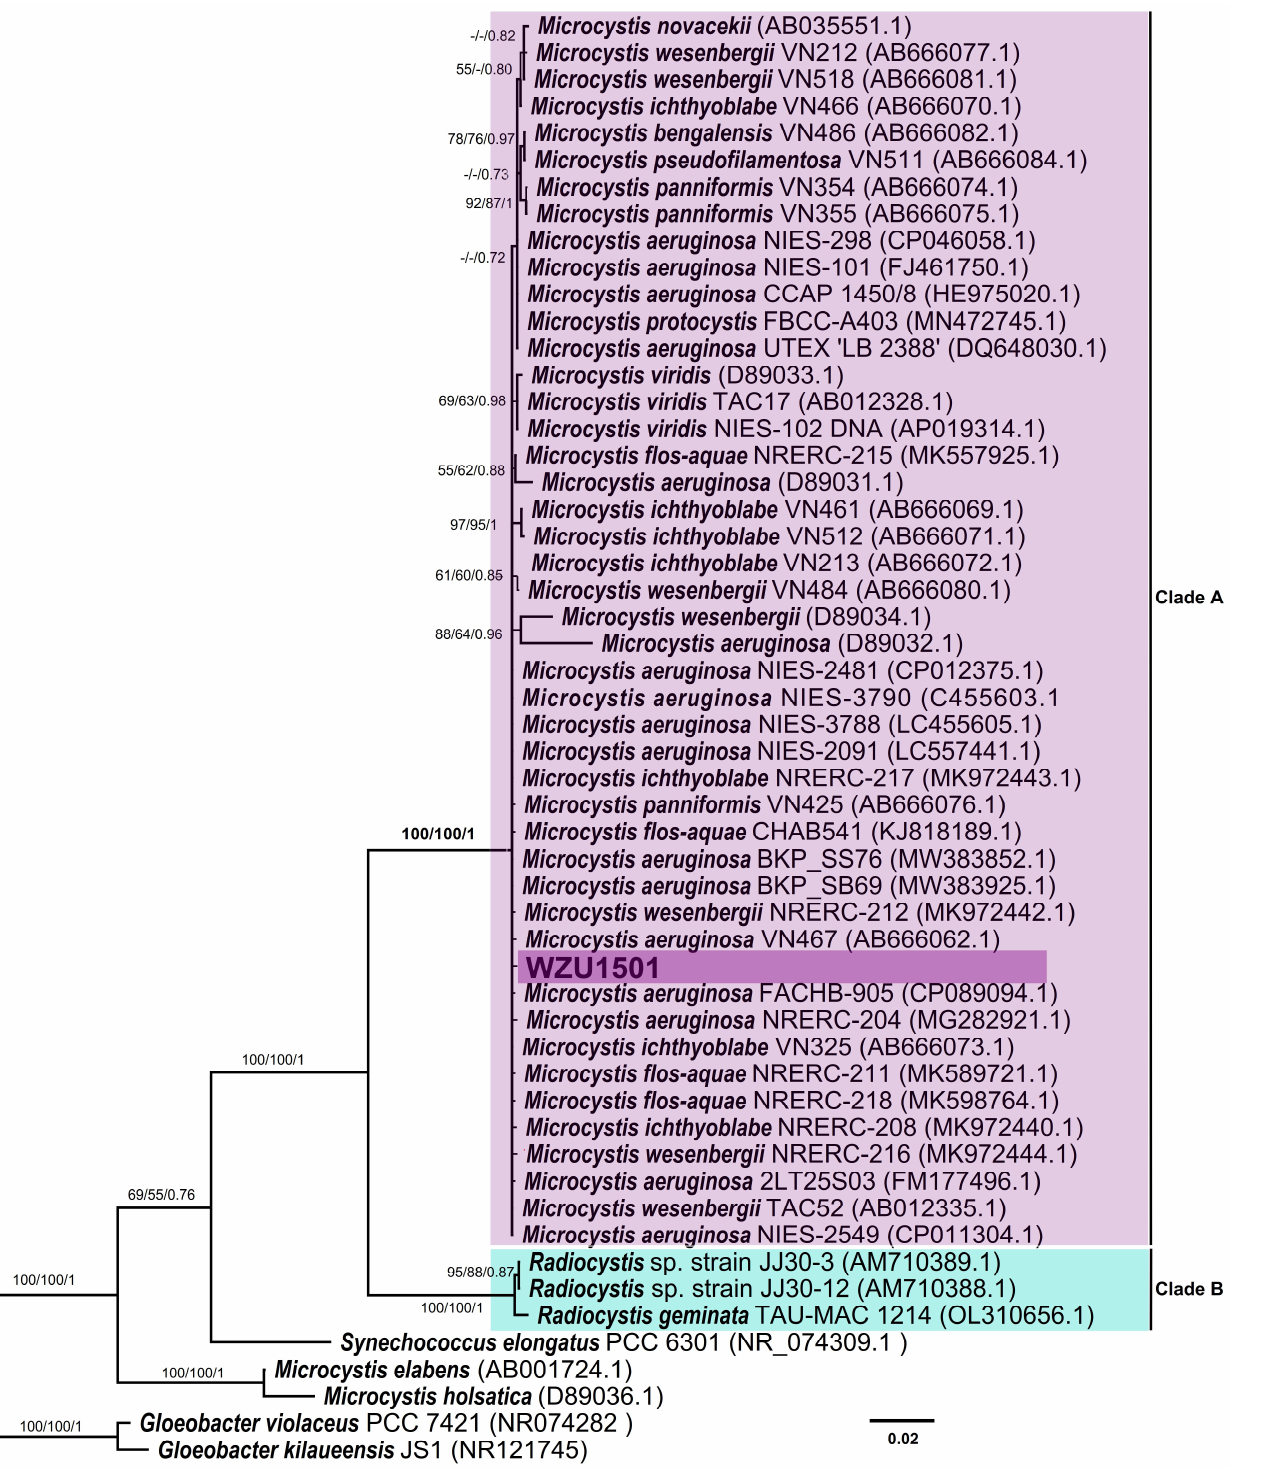
Figure 2. Bayesian inference (BI) phylogenetic tree of WZU 1501 based on 16S rRNA gene sequences (1436 bp). Bootstrap values greater than 50% are showed on the BI tree for NJ/ML methods and Bayesian posterior probabilities. The studied strain was indicated in bold. Bar, 0.02.